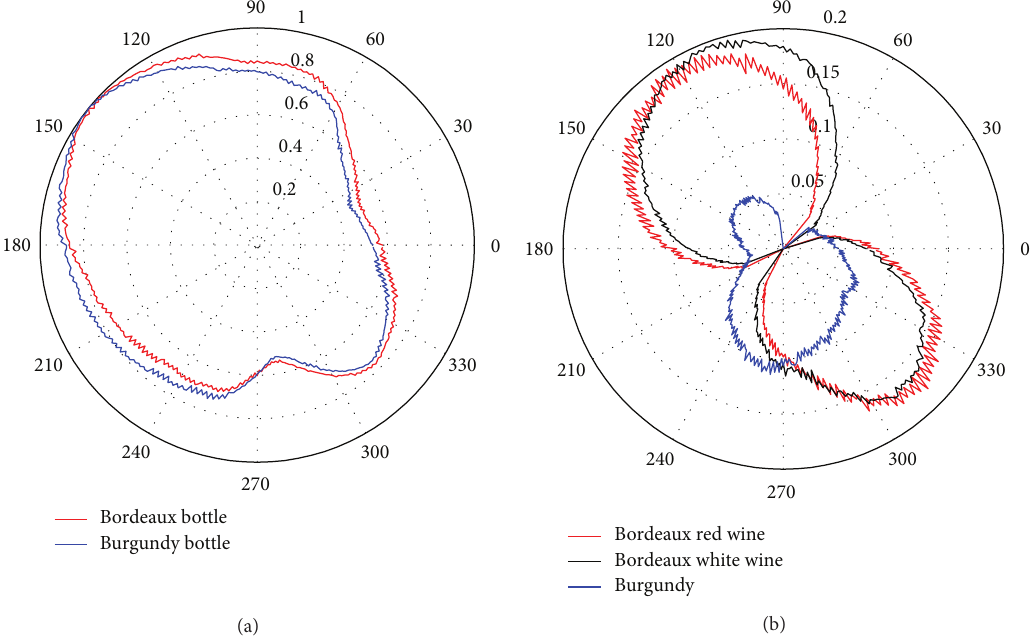
Figure 7: Comparison of the percentage of received power, using tag 1, around three